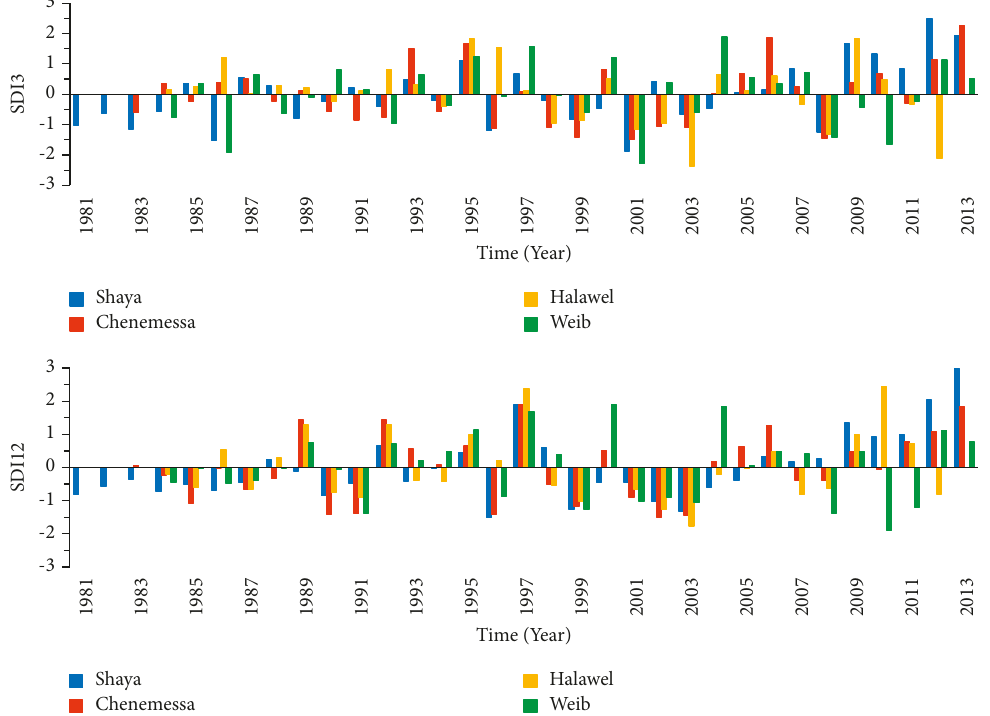
Figure 7: Temporal variation in seasonal (SDI3) and annual (SDI12) for Genale Dawa river basin.